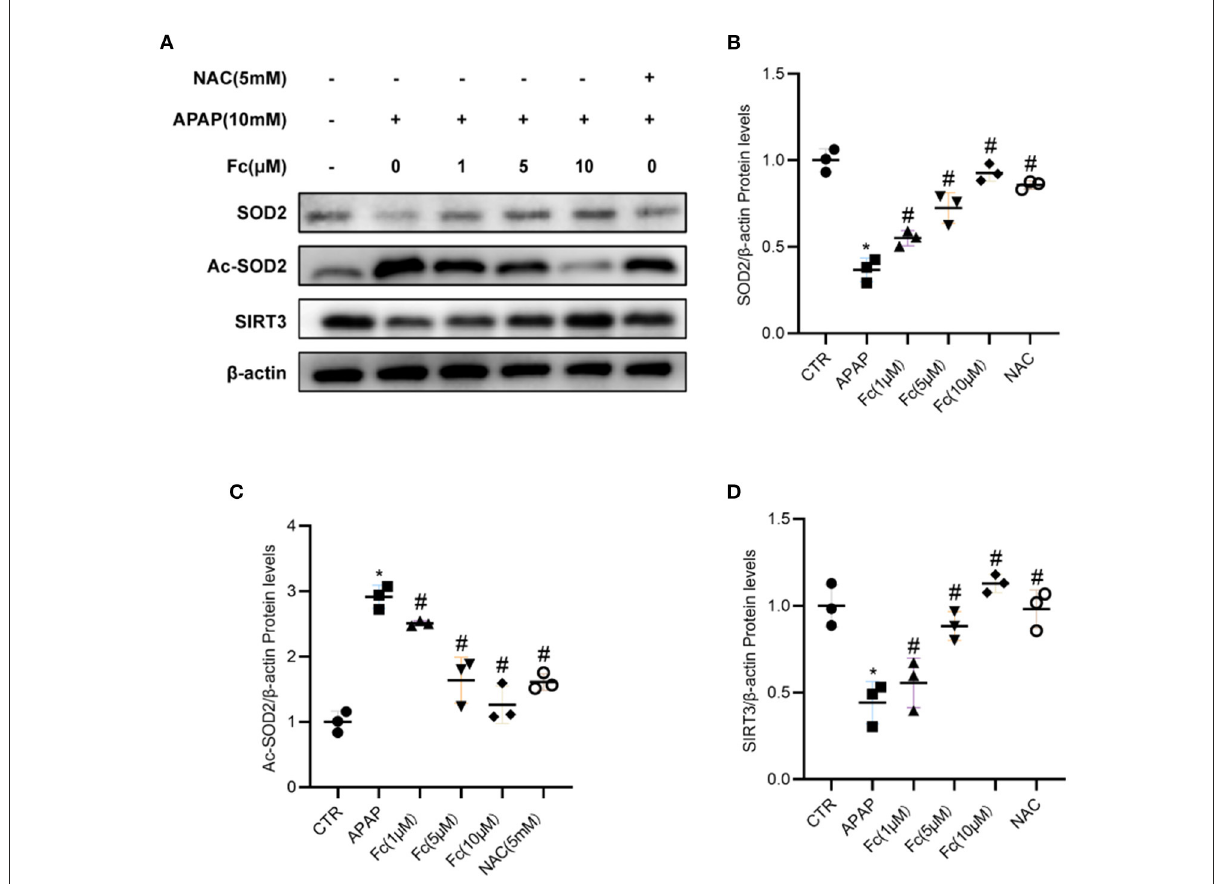
FIGURE7 Notoginsenoside Fc restored the expression of SIRT3/SOD2. (A–D) Western blot analyses and semiquantitative analyses of expression of SIRT3 and SOD2. Results were expressed as mean ± SD. * P < 0.05 vs. control group. # P < 0.05 vs. APAP